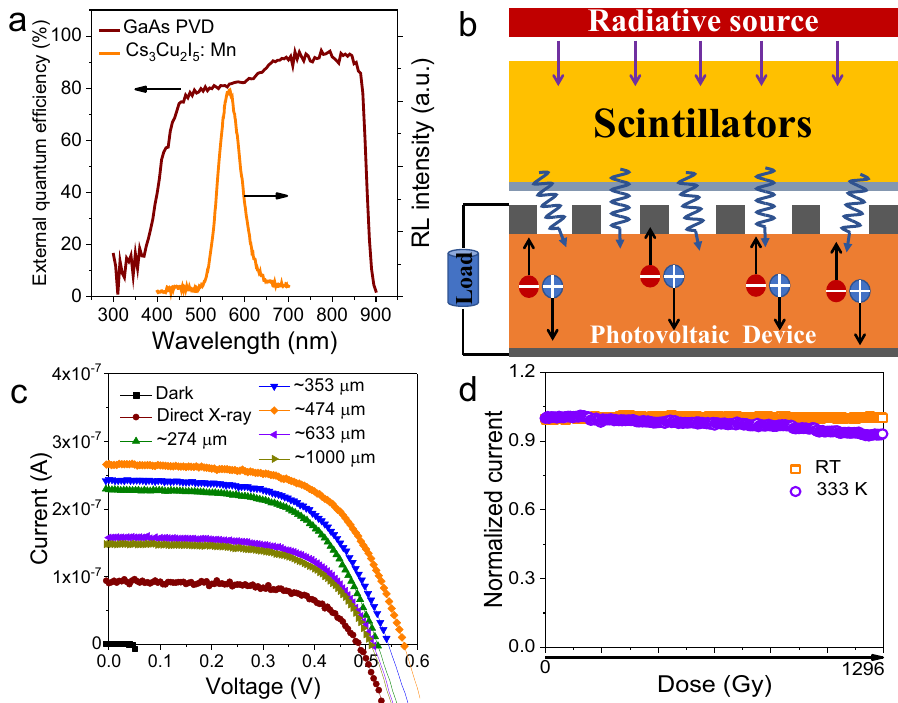
Fig. 5 High performance NB with robust stability. a Schematic structure of the radioluminescent NB. b Spectral responsivity of a GaAs photovoltaic device and the RL of Mn15% fi lm. c I – V curves of the NBs with different scintillator thicknesses. d Long-term operation stability under room temperature and 333